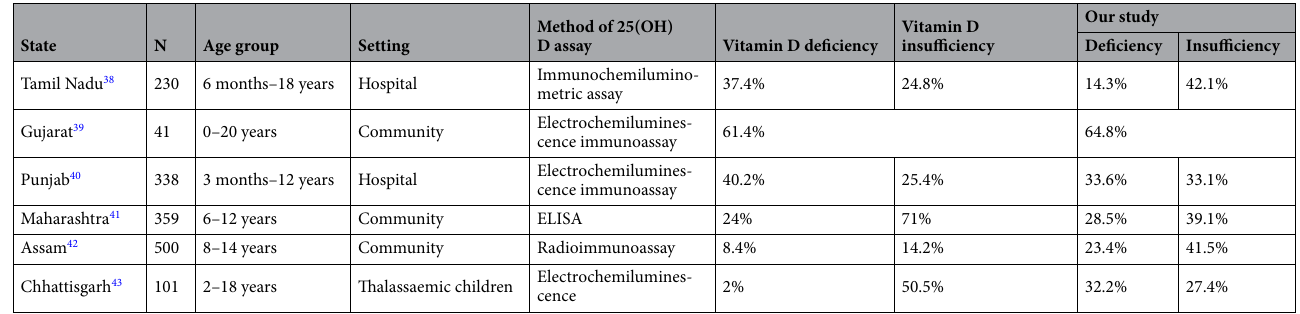
Table 6. Comparison of vitamin D status between present study and earlier Indian